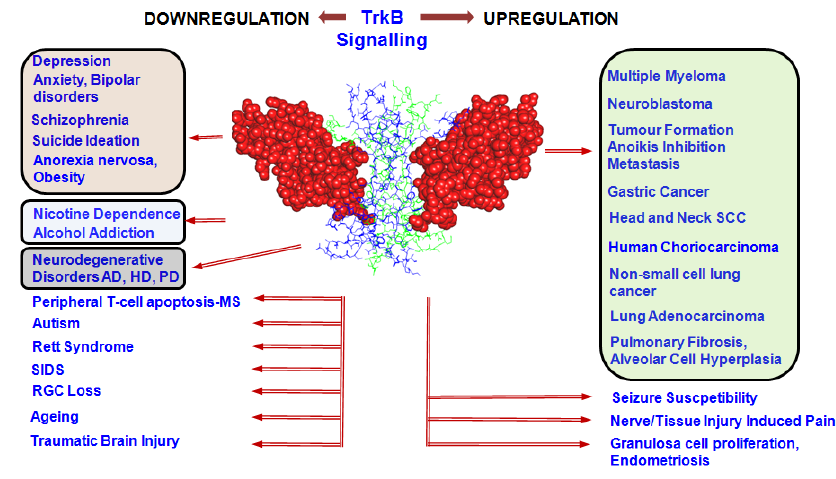
Figure 2. TrkB signalling alterations in various disease conditions. An increase ( right ) or decrease ( left ) of TrkB expression or its signalling may lead to a range of pathological conditions indicating the significance of the maintenance of a fine equilibrium of the TrkB signalling pathway. TrkB (space-filled)-BDNF (wire-frame) dimeric complex. AD, Alzheimer’s Disease; HD, Huntington’s Disease; PD, Parkinson’s Disease; SIDS, Sudden Infant Death Syndrome; RGC, Retinal Ganglion Cell; MS, Multiple Sclerosis; SCC, Squamous Cell